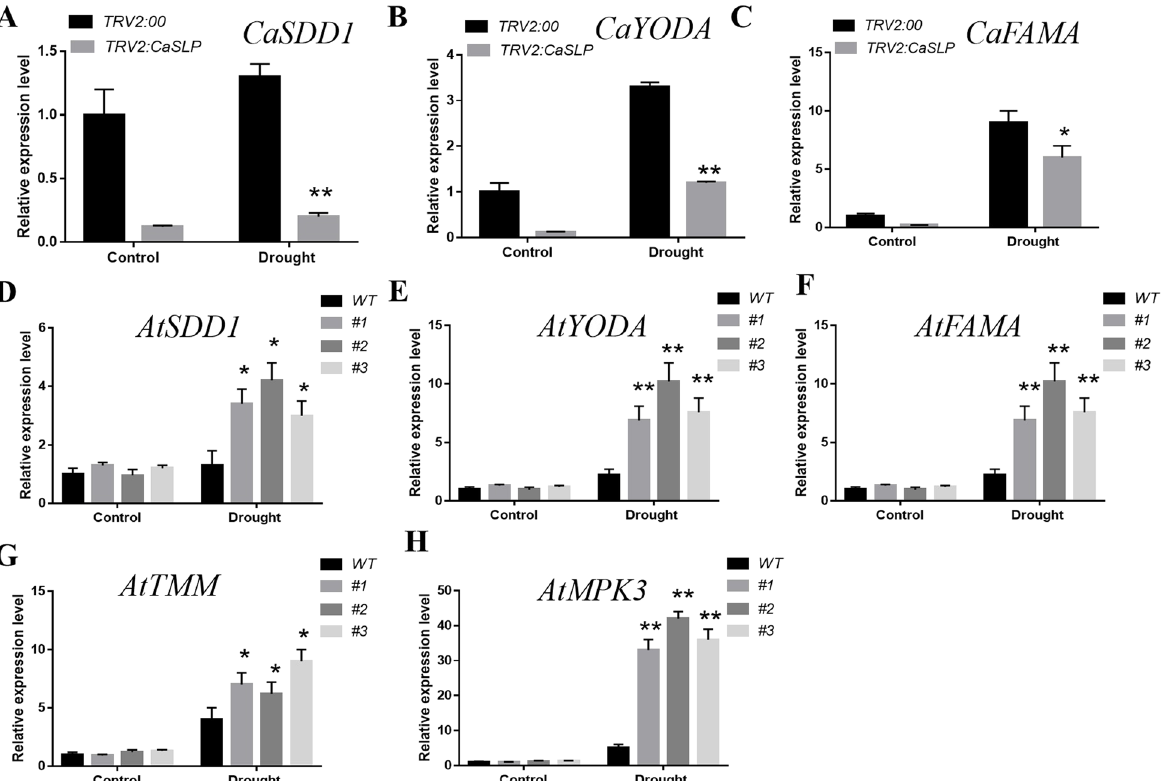
Fig. 6 CaSLP affects the expression levels of stomatal development genes. A - C The transcript levels of stomatal development-related genes, including SDD1 , YODA, and FAMA were analyzed by qRT-PCR in VIGS line (TRV- CaSLP ) and TRV control plants, D - H AtSDD1 , AtYODA , AtFAMA , AtTMM , and AtMPK3 were analyzed by qRT-PCR in transgenic lines and wild-type (WT) plants. Values are means significant difference between the transgenic lines and WT under drought stress (*, P < 0.05; **, P <